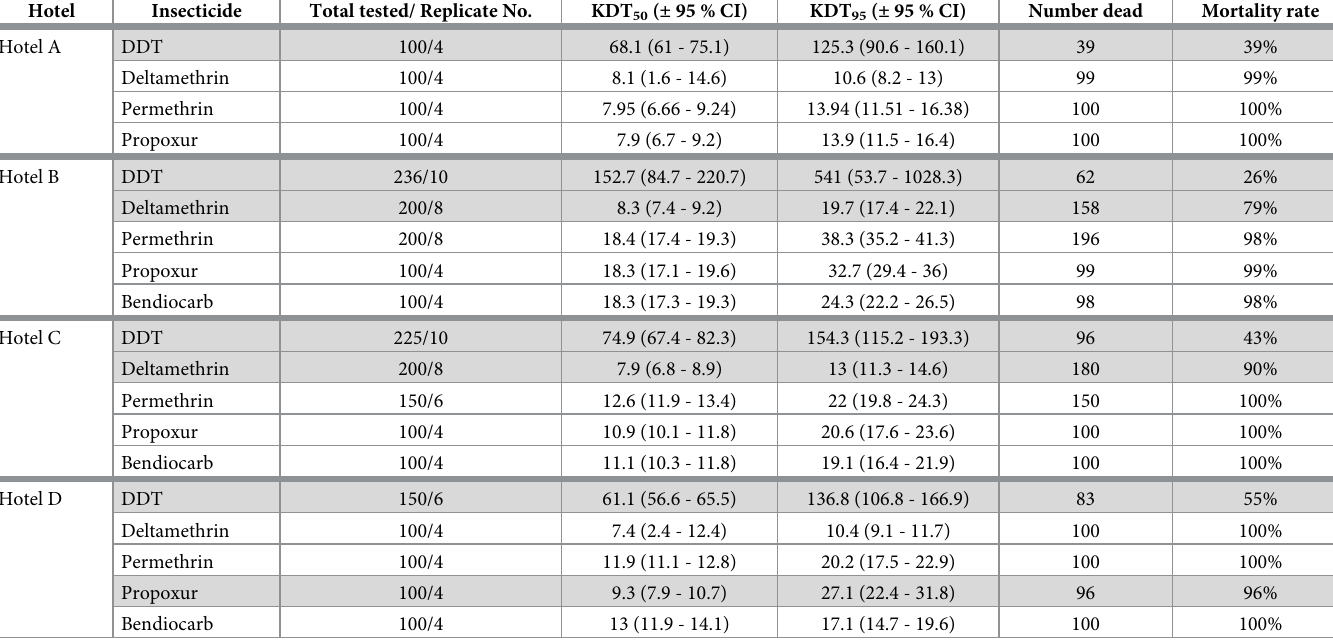
Table 1. Estimates of mortality rates and average exposure time necessary to knockdown Aedes aegypti exposed to insecticides. Shaded rows indicate resistance or suspected resistance requiring confirmation.